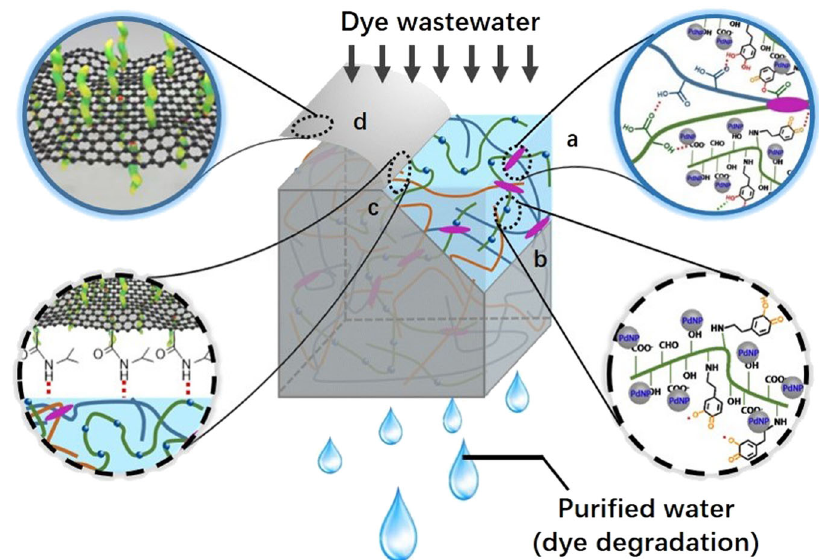
Fig. 1 Schematic of dye degradation by the p(DACO-PDA@Pd NPs- co -AA-SA)@P-GOM hydrogel. a Cross-linking point between DACO-PDA@Pd NPs with PAA and SA. b Immobilization form of Pd NPs on DACO-PDA and a brief diagram of the DACO-PDA@Pd NPs. c Cross-linking between the PNIPAm- co -GO membrane and the surface of the p(DACO-PDA@Pd NPs- co -AA-SA) hydrogel, that is, the PNIPAm- co -GO membrane (P-GOM) was coated outside of the hydrogel. d PNIPAm- co -GO membrane